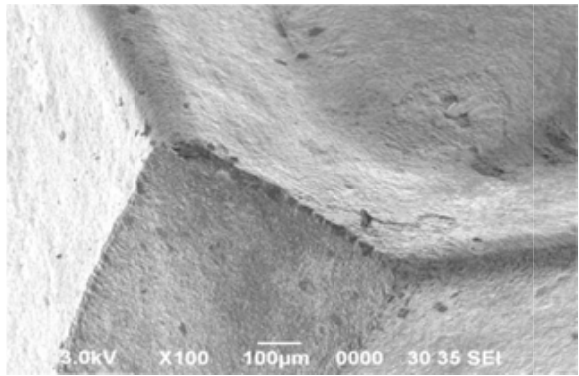
Figure 13. Crater wear at V c D 50 m = min, f D 0:1 mm = rev, and d D 0:3 mm.